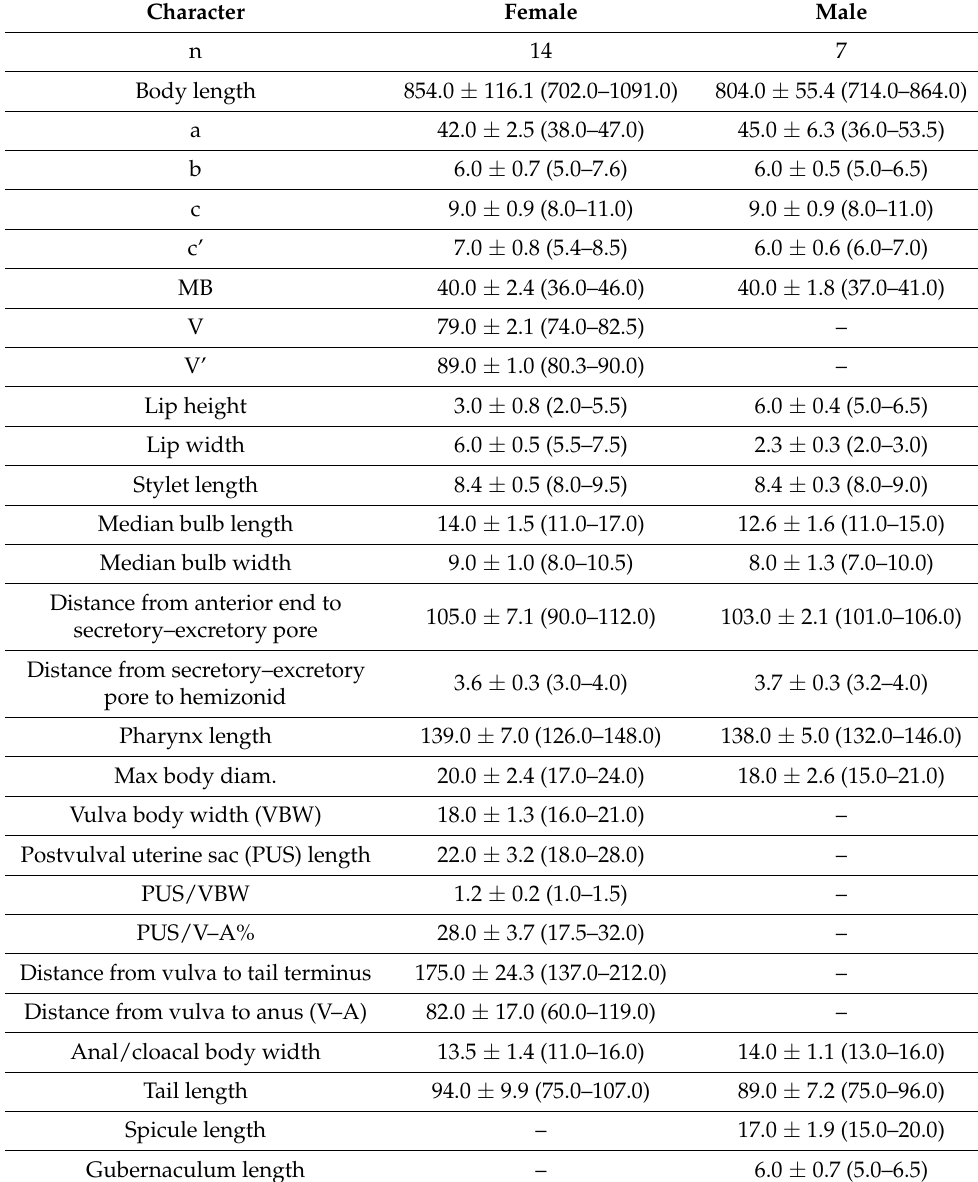
Table 3. Morphometrics of Ditylenchus tenuidens Gritsenko [41] found in this study. All measurements are in µ m and in the form: mean ± standard deviation